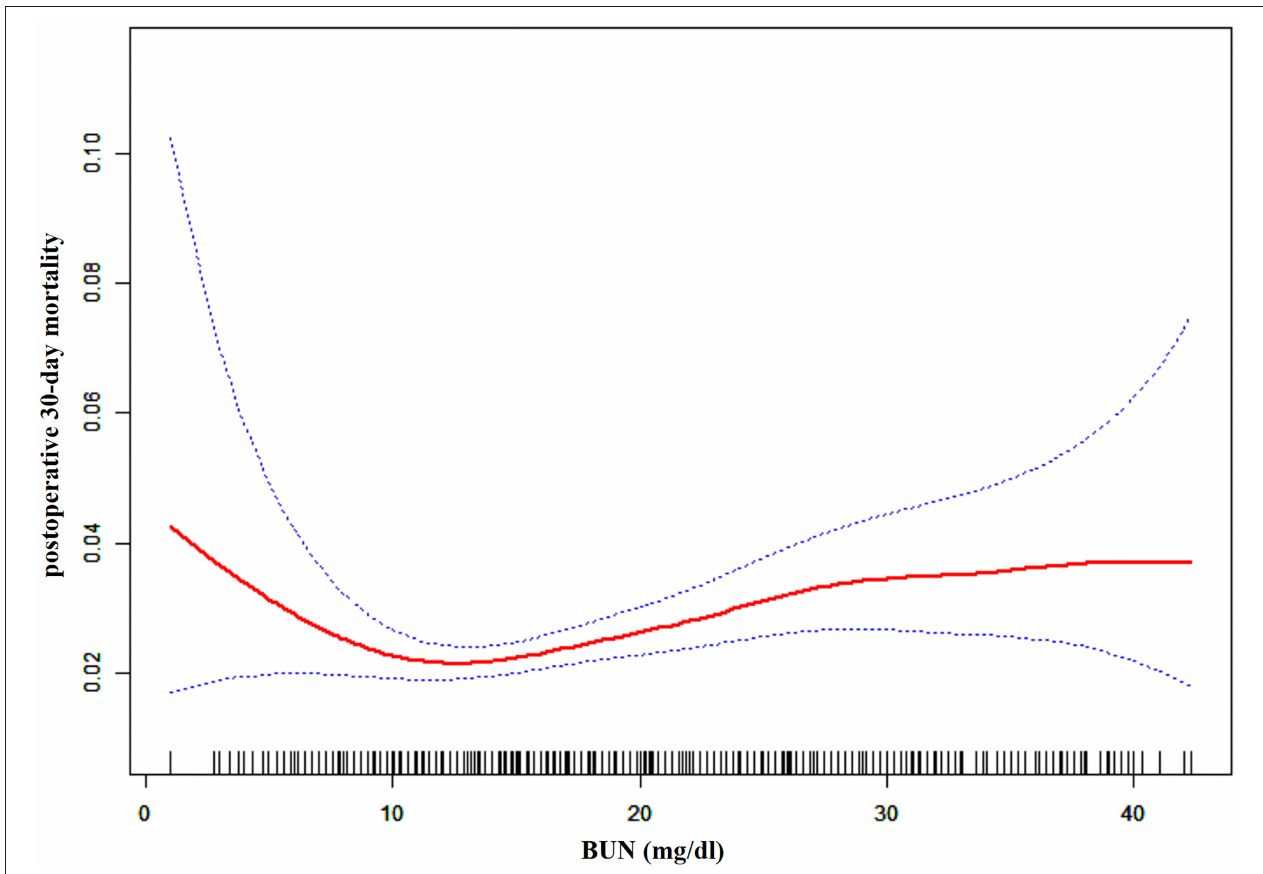
FIGURE 2 | The non-linear relationship between pre-operative BUN and risk of post-operative 30-day mortality.